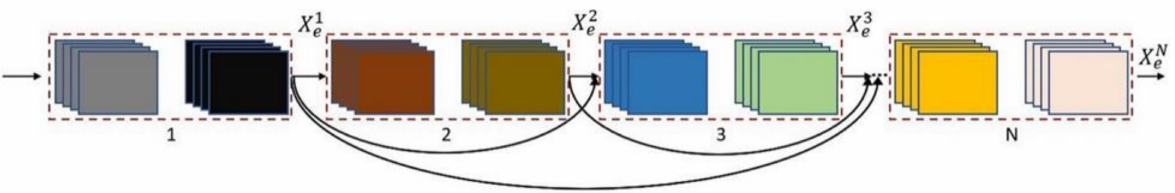
Figure 5. Densely connected convolutional layers of